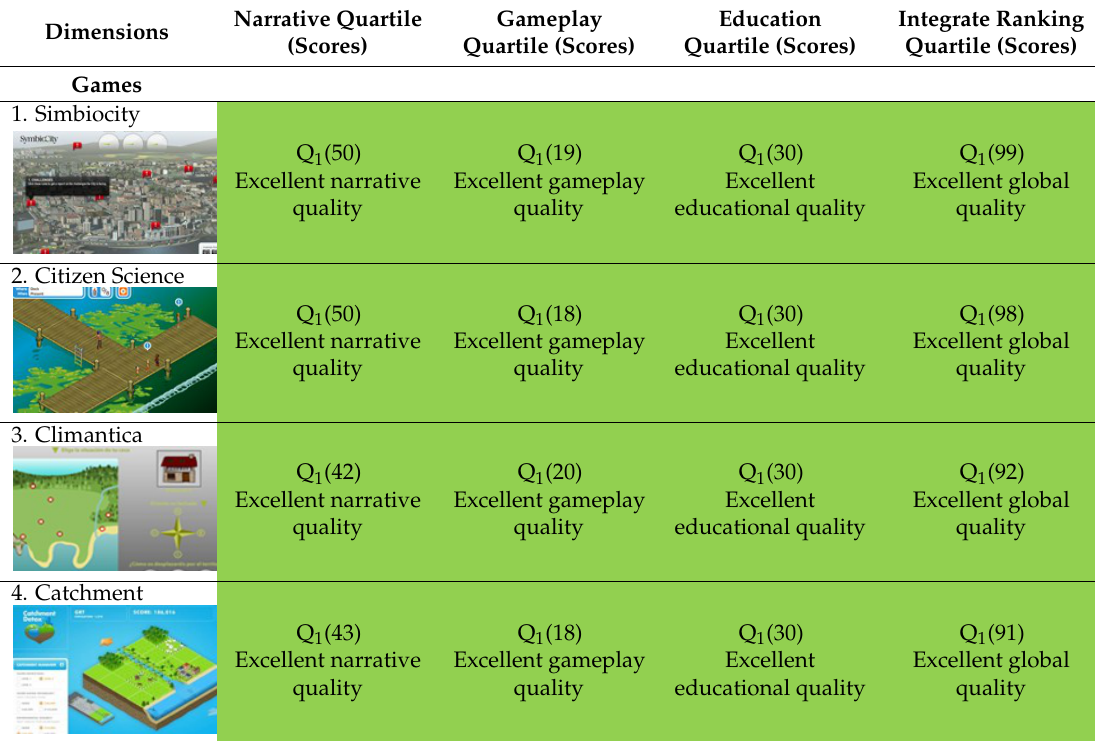
Table 5. Ranking of videogames by dimensios and integrate indicator.